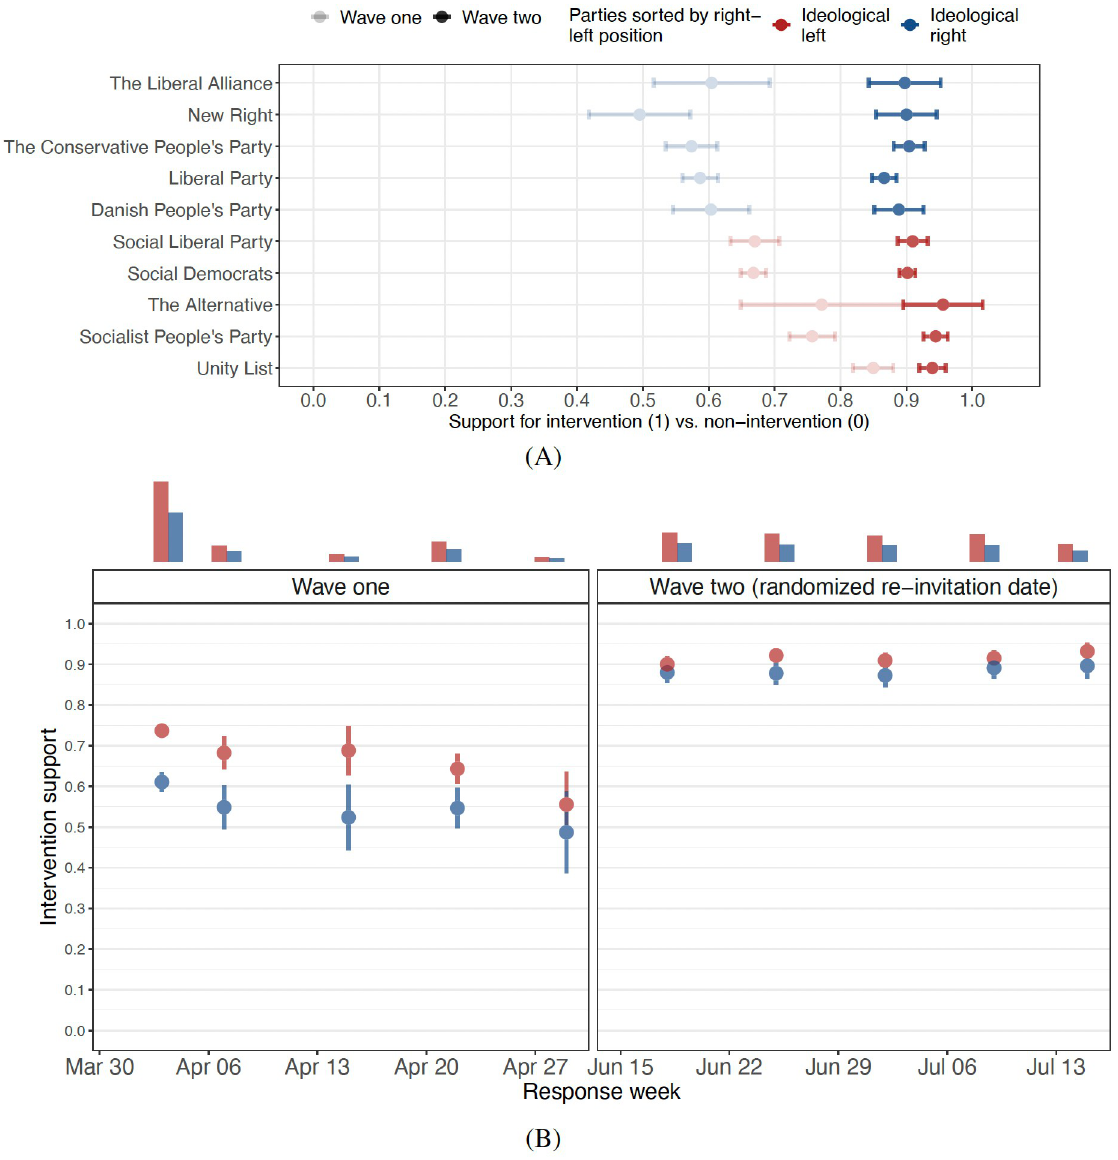
Fig 4. Panel A: Partisan responses to the COVID-19. Panel B: Differences before and after the negative economic shock. Red dots denote estimate means for center-left party voters and blue dots center-right party voters. Lines are 95% confidence intervals and bars reflect group sizes. Parties are sorted by their voters’ stance on economic inequality from necessary (top) to undesirable (bottom) from the Danish Election Survey [23].